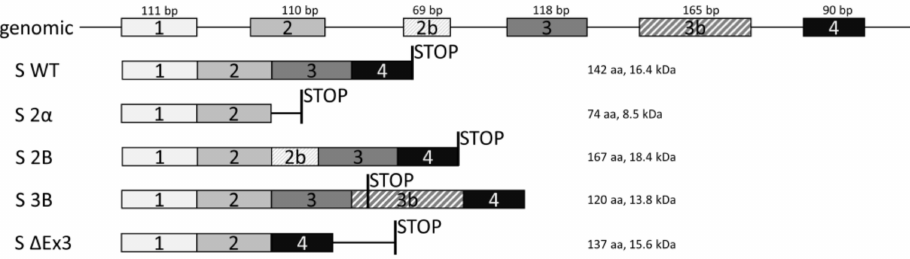
Figure 1. The exon structure of five splice isoforms of survivin. Exons are drawn relative to their size. Vertical bars indicate the site of stop codon of each